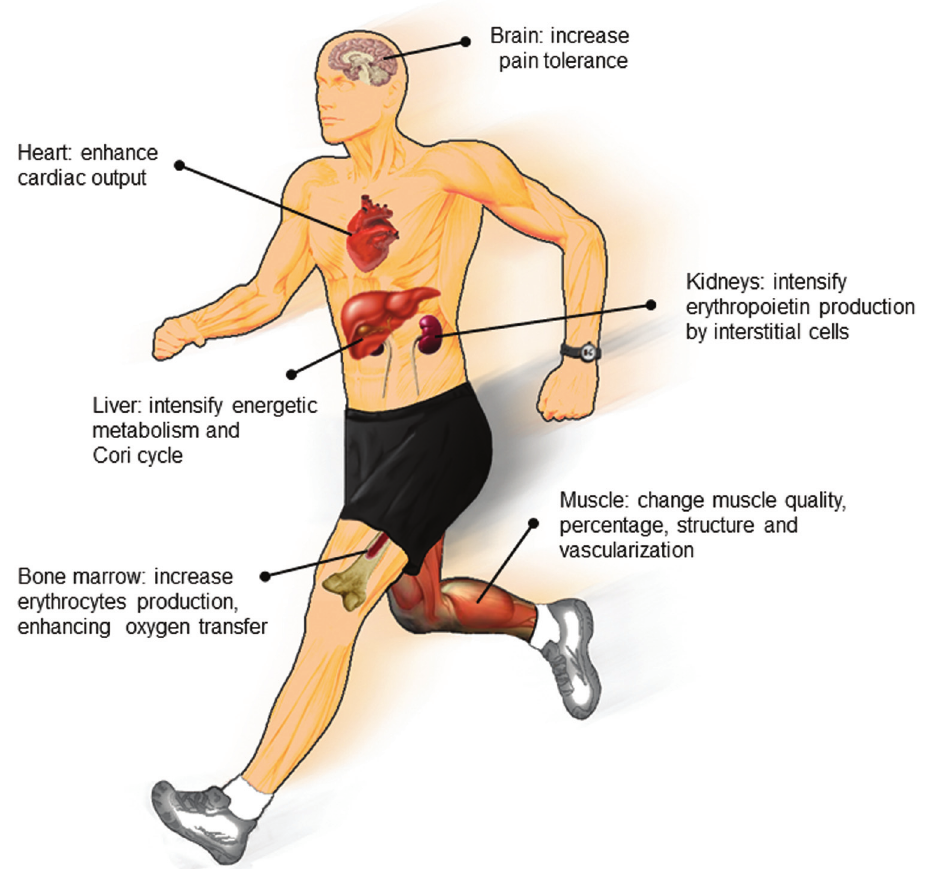
Figure 1. Targeted tissues and organs for gene doping. Main aims of gene doping to enhance sports performance: improvement of pain tolerance (endorphin/enkephalin genes), muscle quality and vascular- ization (VEGF gene and myostatin antagonists) and erythrocyte number (EPO gene). With more genomic understanding, other organs will be targeted in the future, such as heart and kidneys, to increase cardiac output and EPO production, respectively. VEGF = vascular epithelial growth factor; EPO = erythropoi-